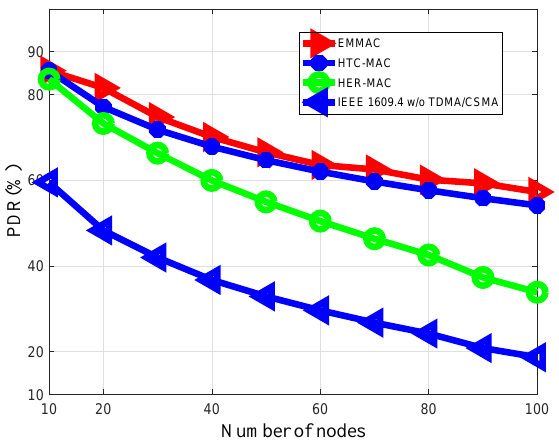
Figure 8. Packet delivery ratio of WSA